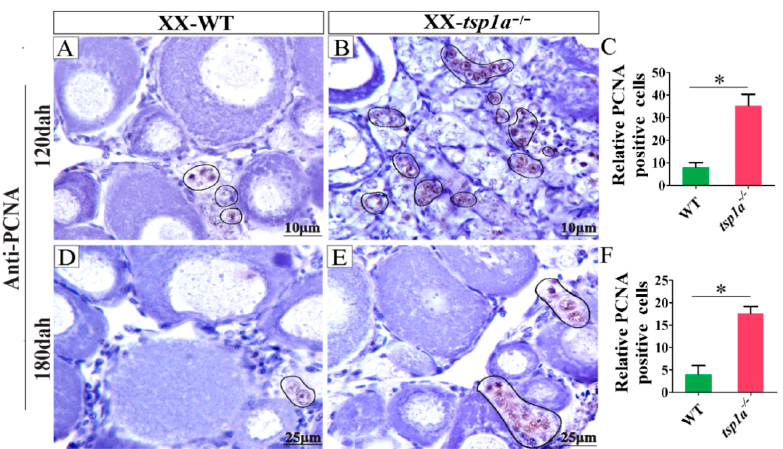
Figure 5. Up-regulation of PCNA expression in tsp1a − / − ovaries in comparison with WT ovaries at 120 and 180 dah. ( A , B , D , E ) Immunohistochemistry analysis. ( C , F ) The statistical analysis of the positive signals ( n = 5, and five sections for per sample were counted). The PCNA positive germ cells were marked by circles. Differences between the mutants and WT were tested by two-tailed unpaired Student’s t -test, * p < 0.05. Results were presented as the mean ± SD in ( C ) and ( F ).